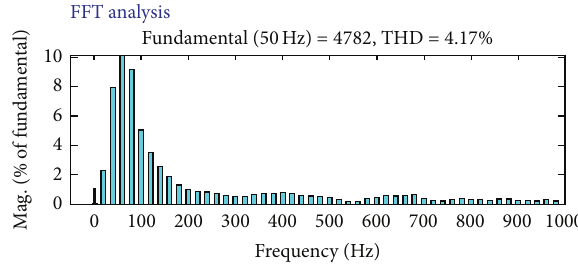
Figure 10: THD when UPQC is not connected to the system.